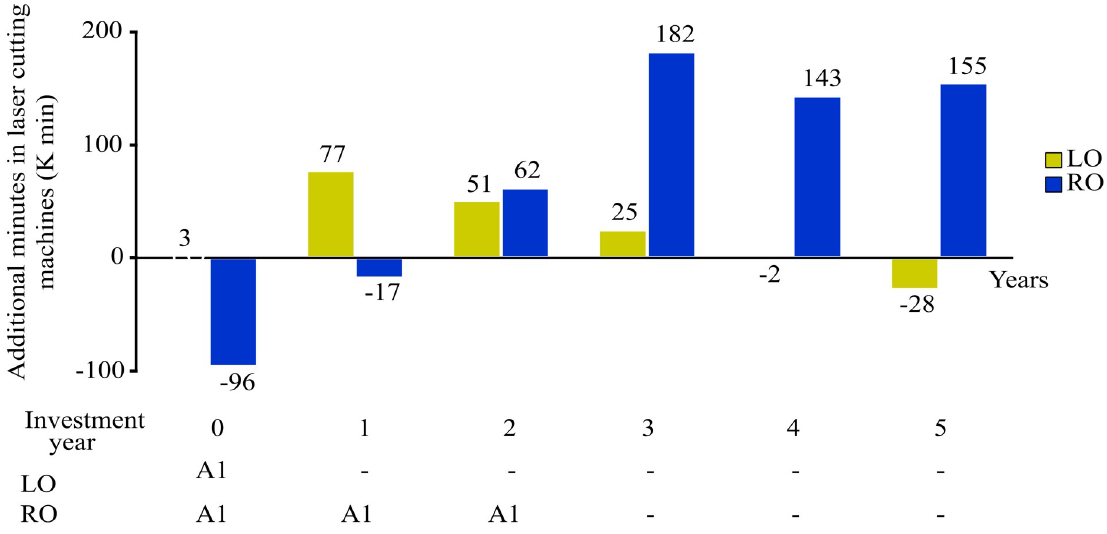
Fig 8. Additional minutes for LO, RO productive